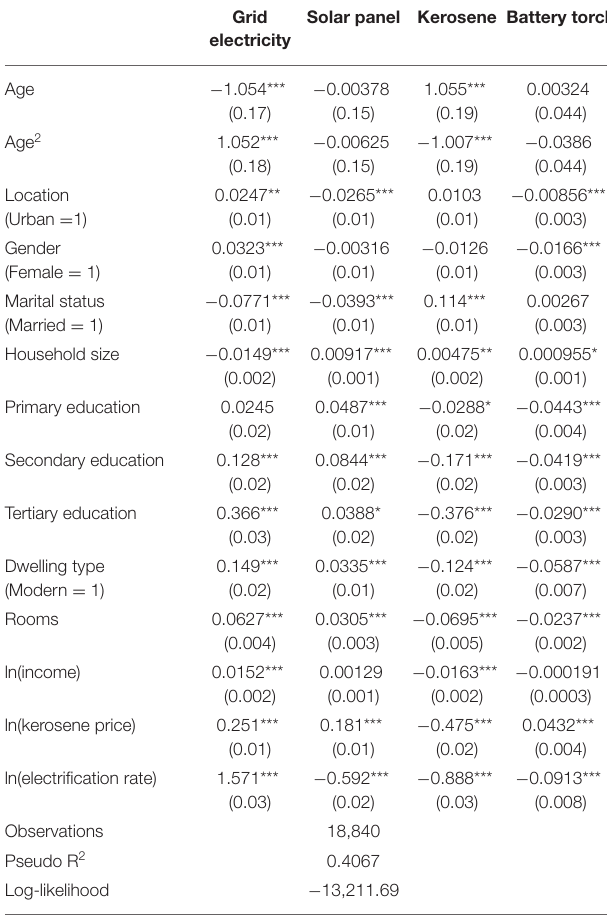
TABLE 2 | Household’s monthly lighting fuel expenditure in Kenyan shillings (KSh). Lighting fuel